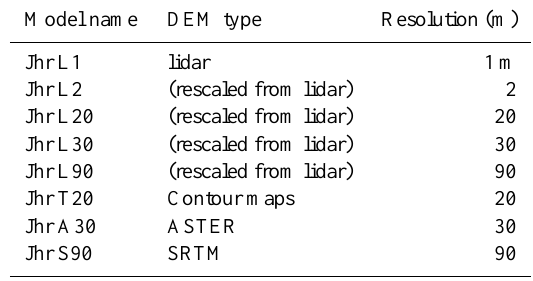
Table 2. Information about the eight digital elevation models used as topographical